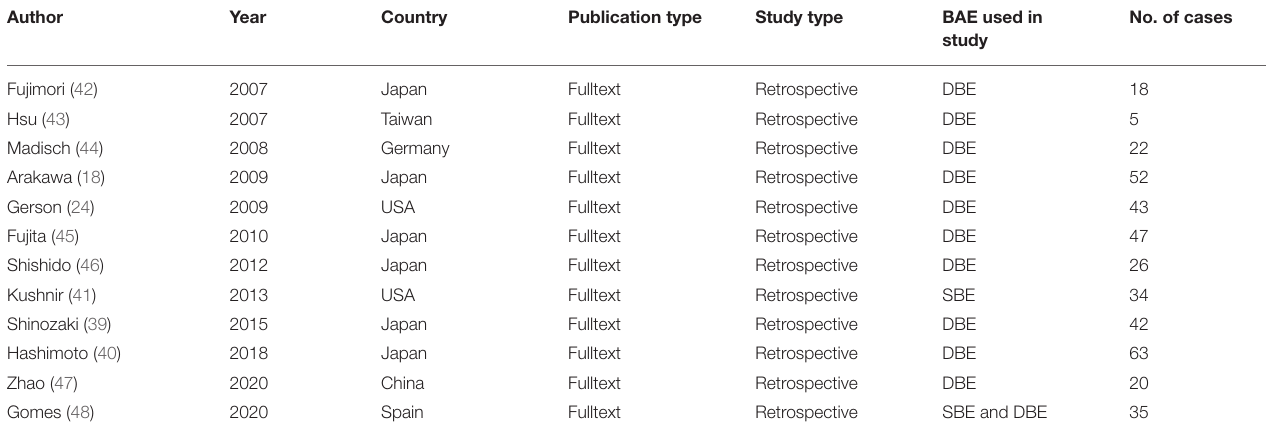
TABLE 1 | Study characteristics.